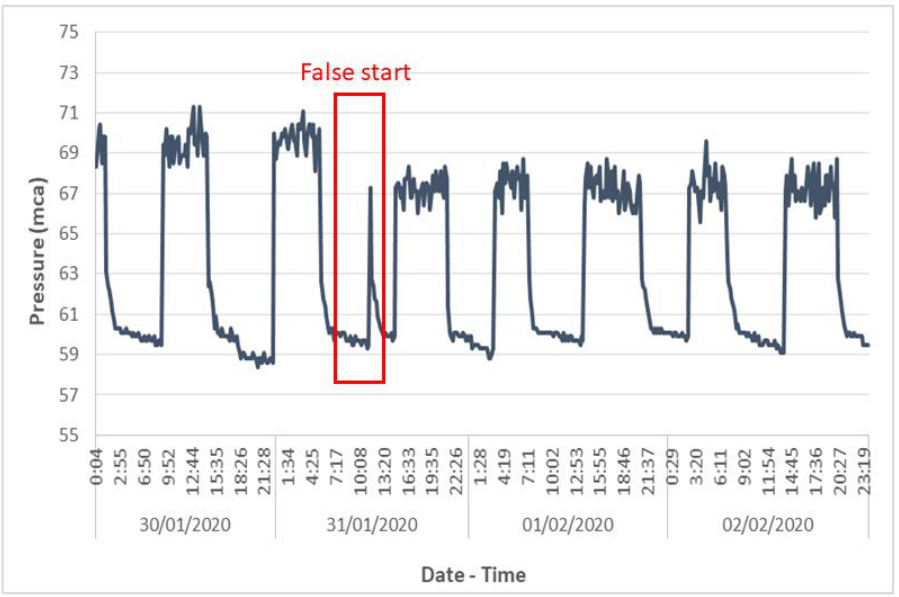
Figure 14. Pump false start.